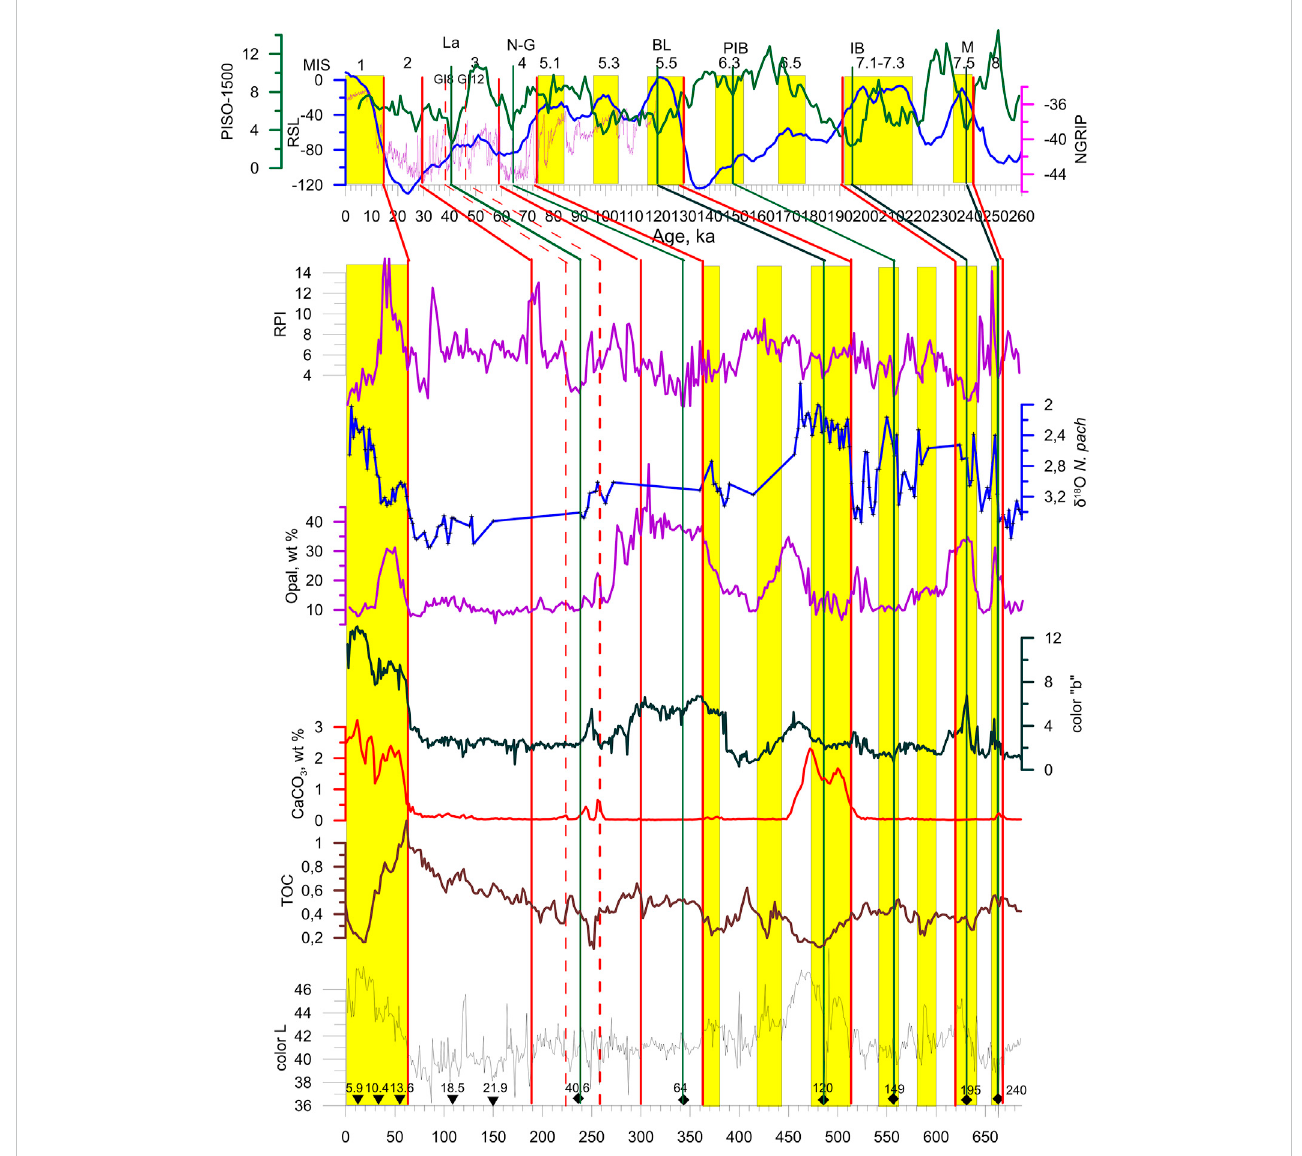
FIGURE 3 AgemodelofcoreLv63-4-2.Atthetop:agesoftheMarineIsotopeStages(MIS)accordingtothestackoftherelativesealevel(SprattandLisiecki,2016), record of Earth ’ s relative paleointensity from Channell et al. (2009) and δ 18 O records of the Greenland ice NGRIP on a GICC05 timescale (Rasmussen et al., 2014). Below, parameters for the examined core versus depth: relative paleointensity, δ 18 O of planktic foraminifera, N. pachyderma (sin.), opal content, color “ L. ” Thegreen linesshow thecorrelationoftheRPIexcursions:La — Laschamp,N-G — Norwegian- “ b, ” CaCO 3 andtotalorganiccontent (TOC),andcolor Greenland, Bl — Blake, PIB — Post-Icelandic basin, IB — Icelandic basin, and M — Mamaku. Red lines indicate the correlation of the MIS